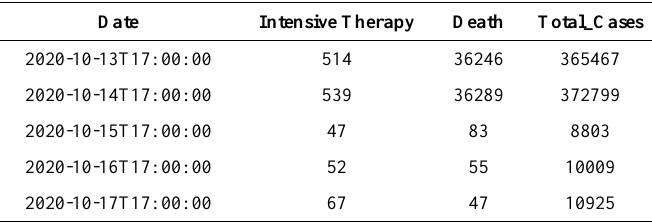
Table 5. Example of Civil Protection